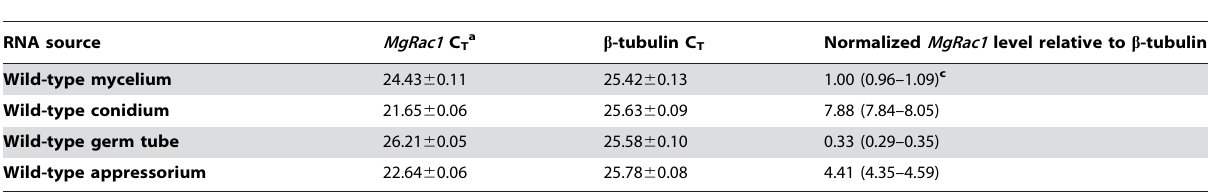
Table 2. Real-time RT-PCR quantification of MgRac1 expression in M. grisea .